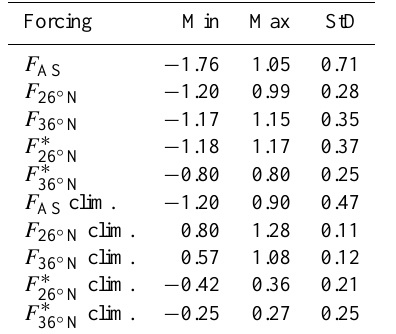
Table 1. Table of minimum, maximum (PW) and StD (PW) values of the heat transports used (detrended and with the mean removed) for the AV (OCCAM) and FV (RAPID-based) box models. Trans- ports into the box (ocean) and downwards (air–sea) are positive.